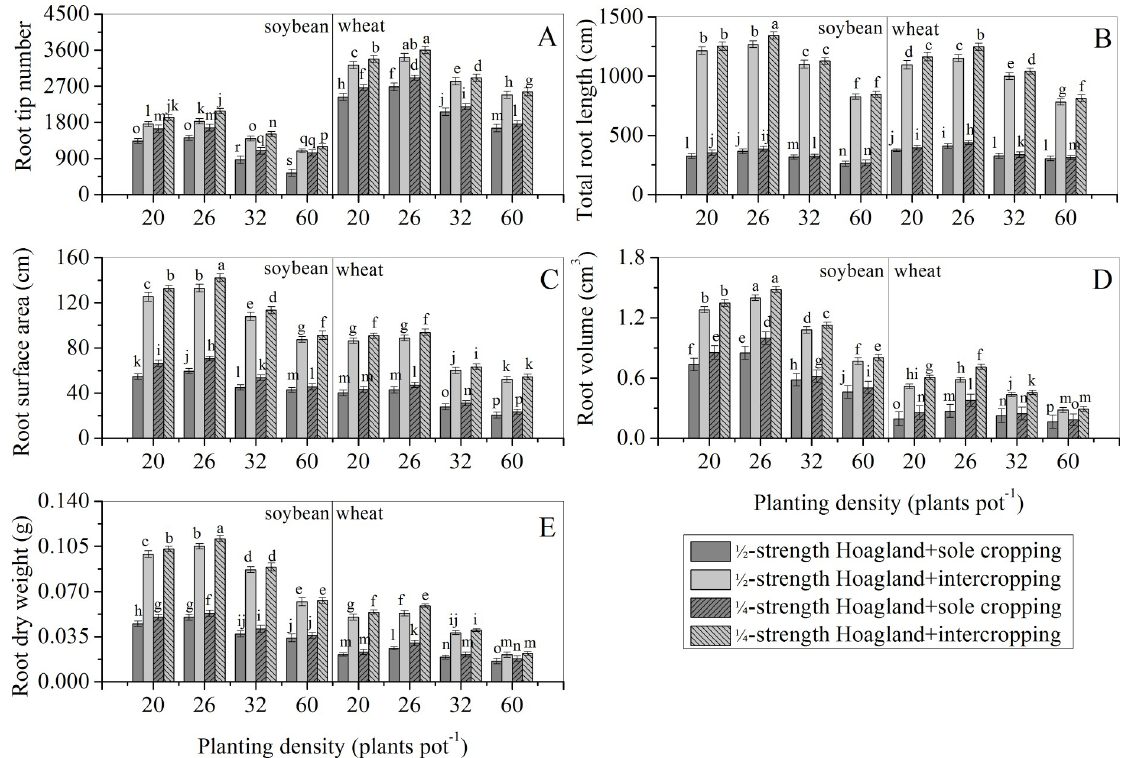
Fig 2. Effects of nutrient level and planting density on underground modules of soybean/wheat sole cropping and intercropping populations. Data are expressed as means ± standard errors of five replicates, and the error bars represent standard errors. Treatments marked with the same letter are not significantly different according to Fisher’s LSD test ( p <